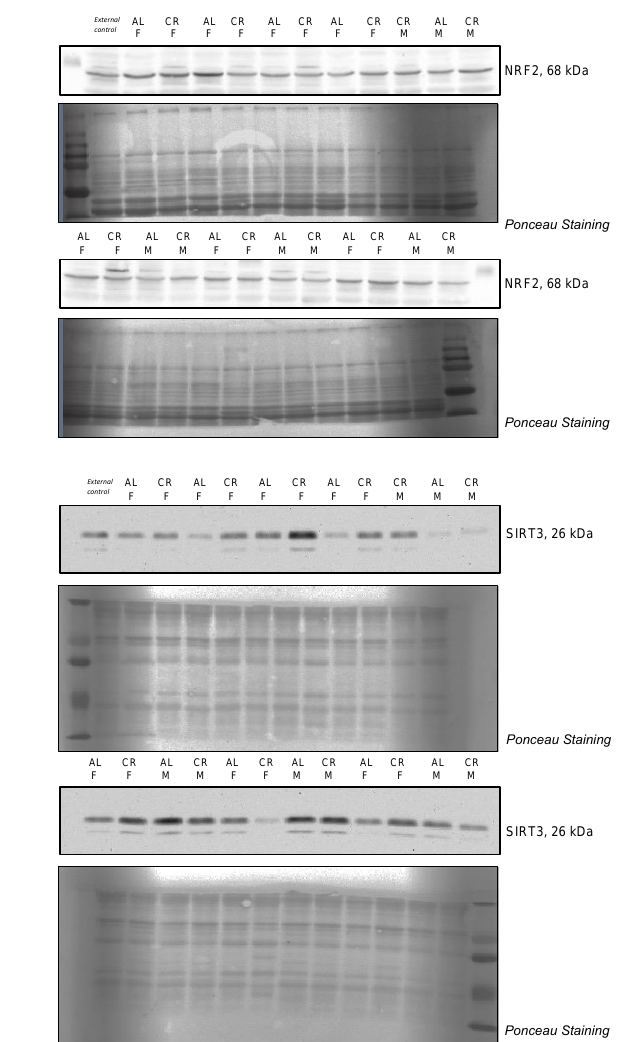
Figure 4. Protein levels of ( A ) NRF2 and ( B ) SIRT3 antioxidant factors. Boxplot showing the protein levels of NRF2 and SIRT3, and representative bands of the Western blot. Two-way ANOVA was performed to assess for significance. Abbreviations: S, sex differences; AL: ad libitum; CR: caloric restriction; F: female; M: male. * Significant difference between calorie-restricted and control group. mRNA levels of Map1lc3a and Sqstm1 (Table 5), and protein levels of LC3 and Caspase 3 (Table 6) were measured as key makers of autophagy and apoptosis. No